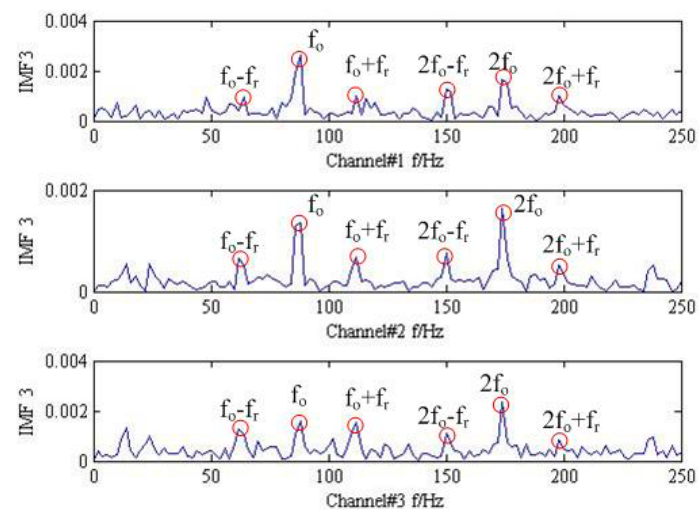
Figure 12. The frequency analysis result about the IMF3 by the proposed method.